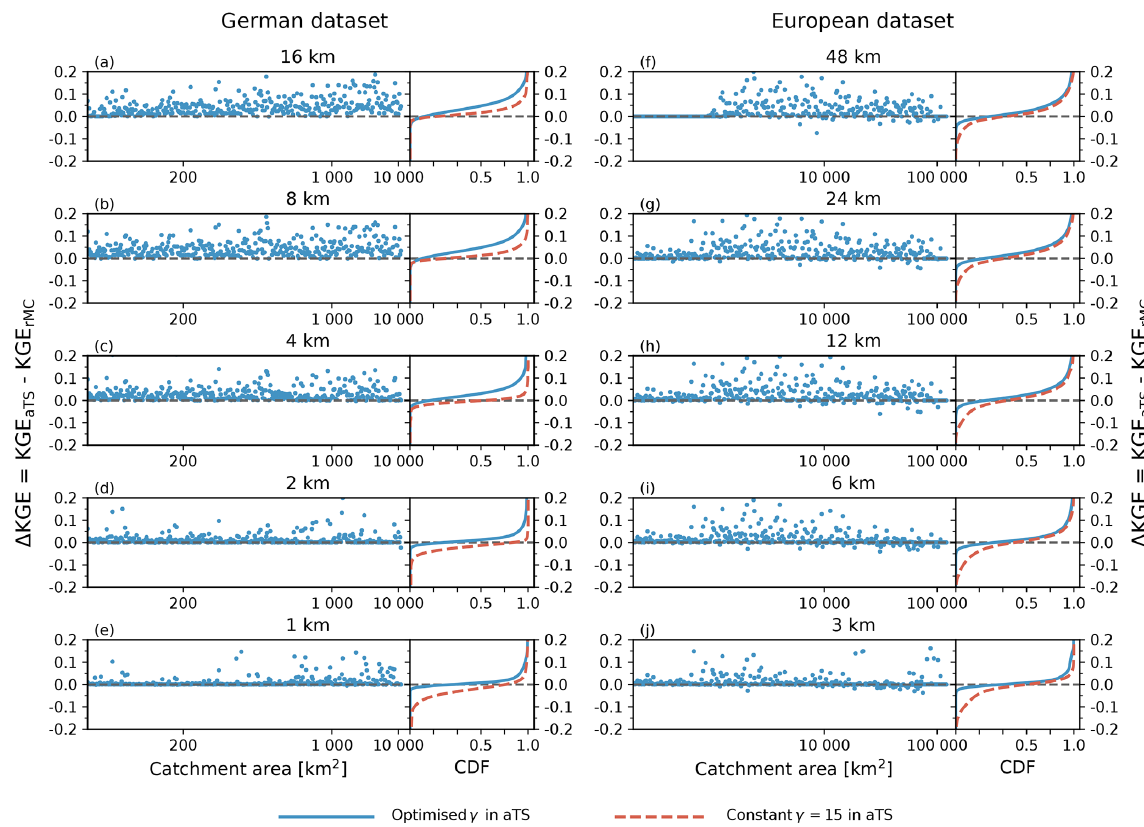
Figure 6. Differences in KGE between the multiscale routing model mRM using a optimised parameter γ , constant parameter value γ = 15, and the original Muskingum–Cunge routing scheme (rMC) implemented in the mesoscale hydrologic model mHM for the German (left column) and European datasets (right column). The (cid:49) KGE values between the aTS and rMC using optimised parameter values on each basin and at each resolution are shown for the respective basins on the left of each panel; basins are sorted according to catchment area (note the logarithmic scale). Cumulative distribution functions of (cid:49) KGE between the aTS and rMC using optimised parameter values (solid blue line) and the aTS with a constant parameter, and rMC with optimised ones (dashed red line) are depicted on the right of each panel. The line at KGE = 0 (dashed black line) is added for